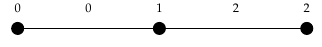
Figure 2. 3-TEMC labeling of P